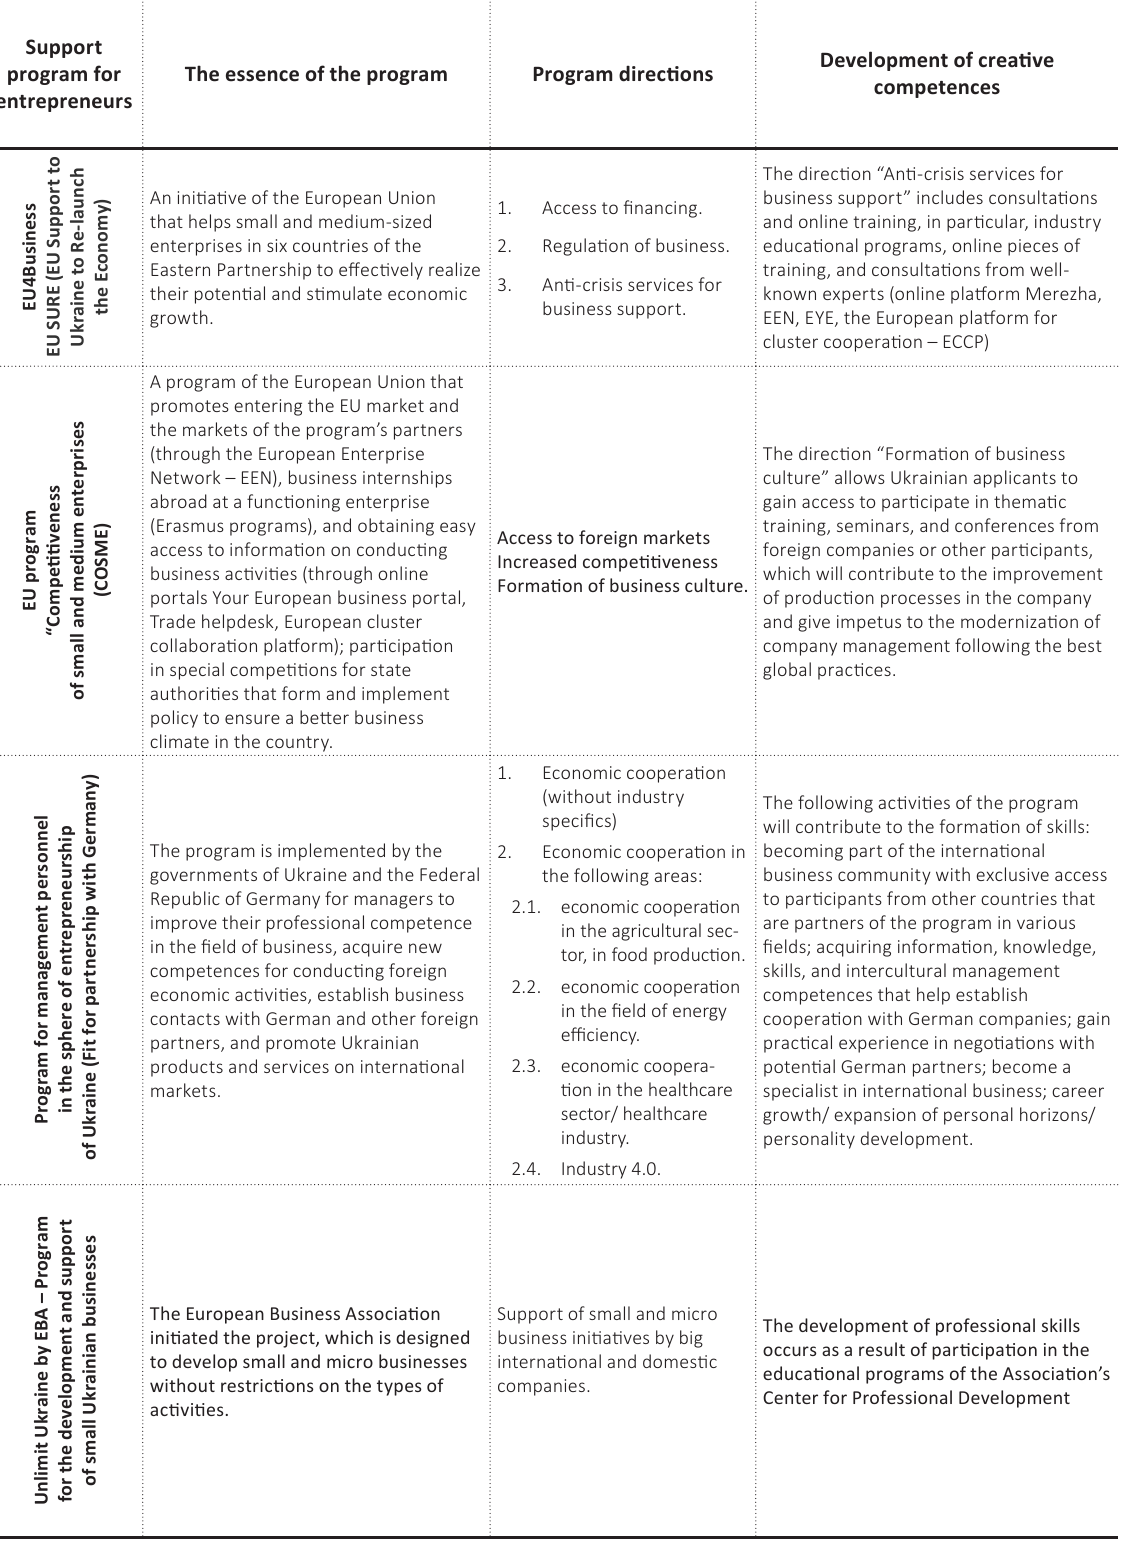
Source: Developed by the